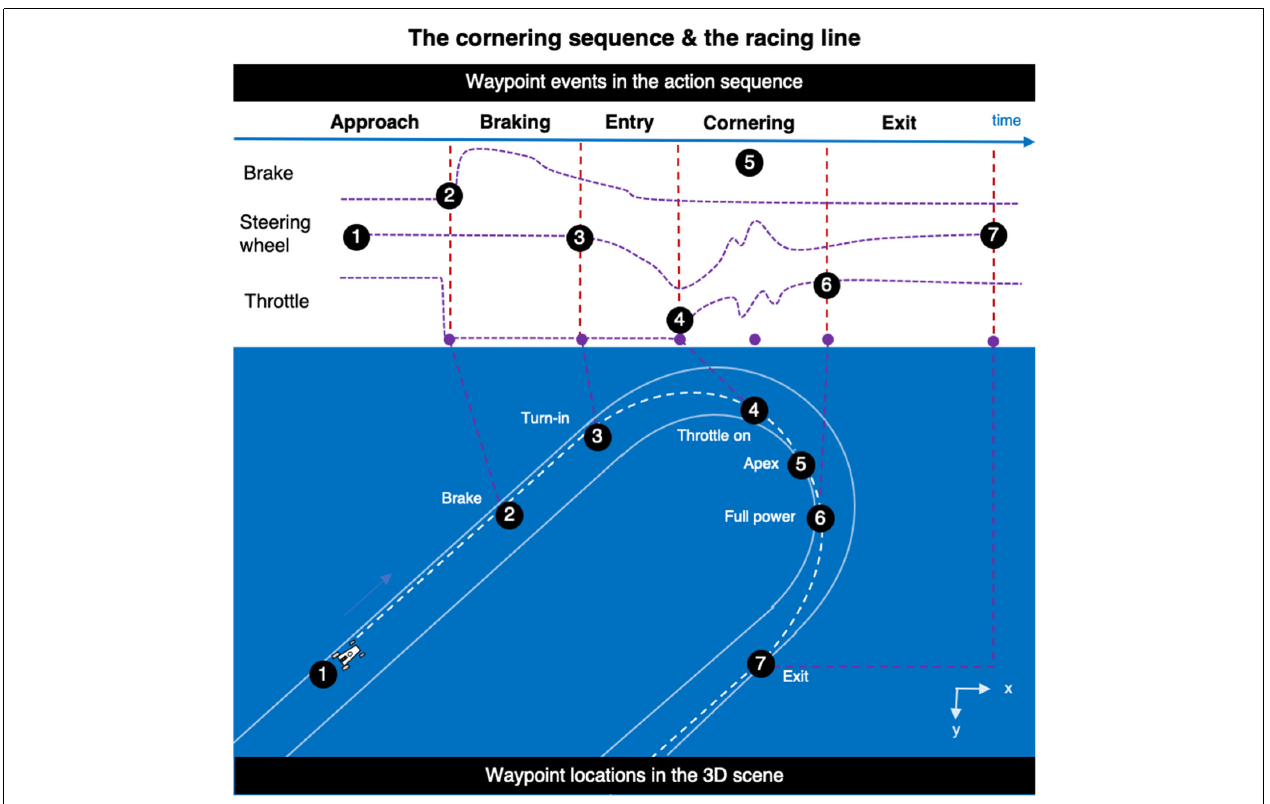
FIGURE 4 | Waypoints. The basic cornering sequence can be partitioned into waypoint locations to sequence the racing line. These have a fixed location in the 3D scene. They are the locations at which critical control actions are performed. Operationally, waypoints can, therefore, be identified in vehicle telemetry time series on the basis of a small number of signals. What determines the placement of waypoints (for a given driver for a given bend), the mechanisms that generate the pattern of waypoint locations is the main concern of this article.